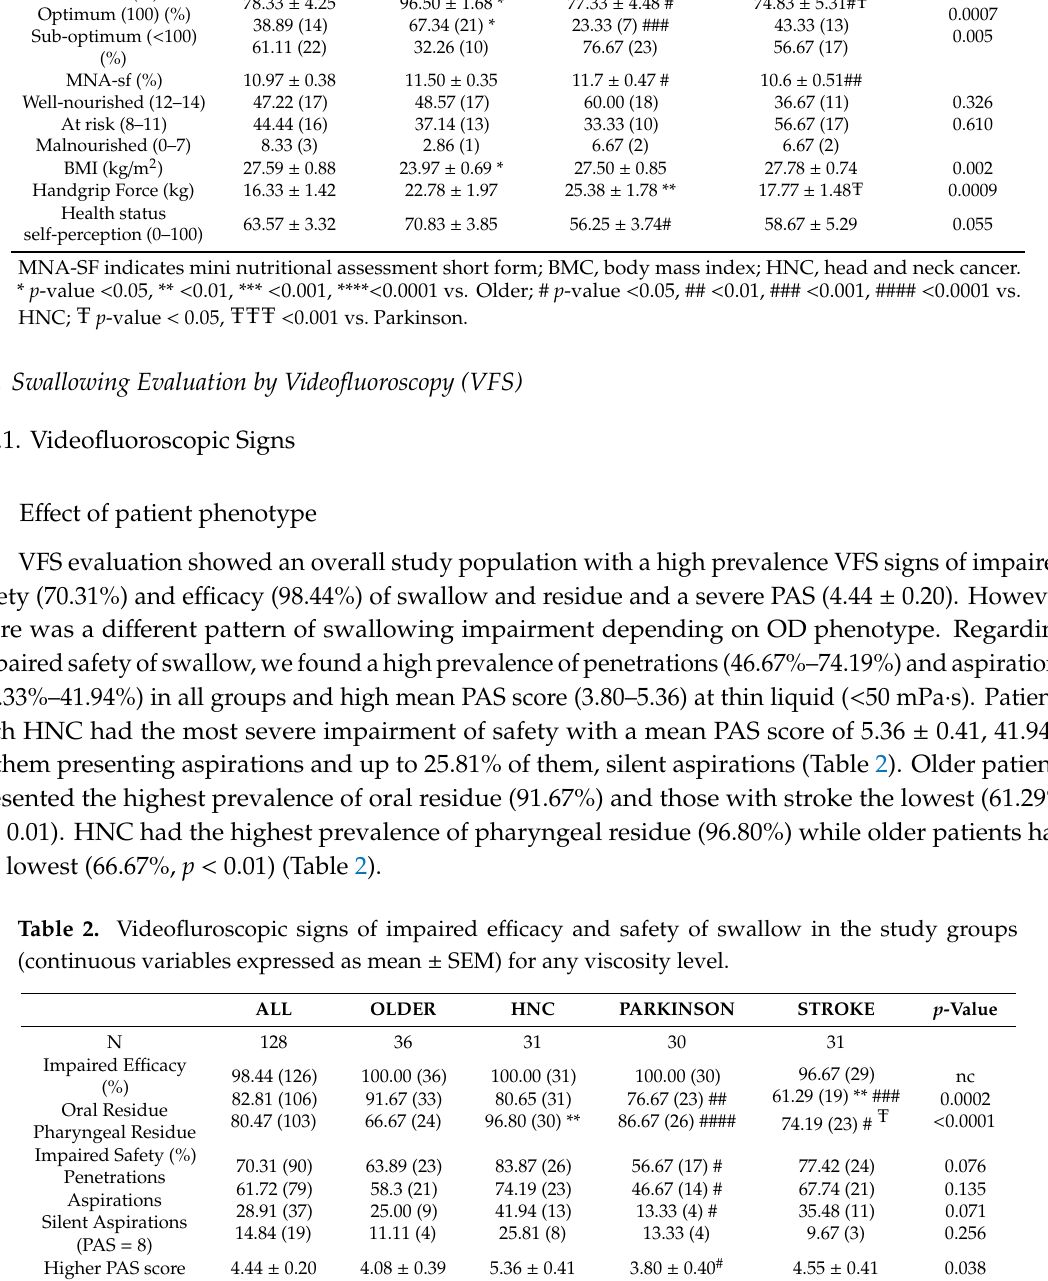
Table 1. Demographic characteristics of the study population (continuous variables expressed as mean ± SEM).